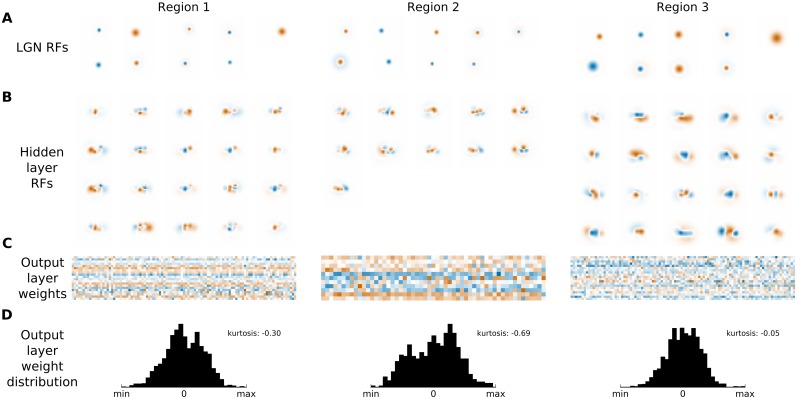
Composition of RFs estimated by the HSM.(A) The kernels of LGN HSM units fitted to the 3 imaged regions in V1. (B) The linear kernels of the hidden units of the HSM fitted to the 3 imaged regions in V1. These have been calculated as the sum of the difference-of-Gaussians kernel of the LGN units weighted by the fitted connections from the LGN to hidden units. (C) The weight matrices between the hidden and output units for HSMs fitted to the 3 imaged regions. For each output neuron the weights were individually normalized. (D) The histograms of the weight matrices shown in C with calculated kurtosis of the respective distributions. Overall, the RFs of the intermediate units in the fitted HSM differ somewhat from standard descriptions of V1 simple cell RFs estimated by rLN (or similar) methods. However, it is possible that the RFs of the hidden units are combined in the HSM output layer to form RFs that—when linearized—match those obtained via the rLN method. To verify this, we performed a rLN analysis using the training set of images and the corresponding responses of the fitted HSM, thus obtaining a linear estimate of the HSM-derived RFs. Fig 8 shows the RFs obtained via the rLN method directly from the data (A columns) and using the corresponding HSM predictions (B columns) for neurons in the first imaged region. Neurons for which a linear RF could be estimated showed a close match between rLN and HSM estimations. This indicates that the fits of the HSM are compatible with the previous rLN results. At the same time, the HSM significantly outperforms response predictions of the rLN model for most neurons, indicating that non-linearities in the HSM, which cannot be captured by the inherently linear rLN model, provide significant performance improvements.